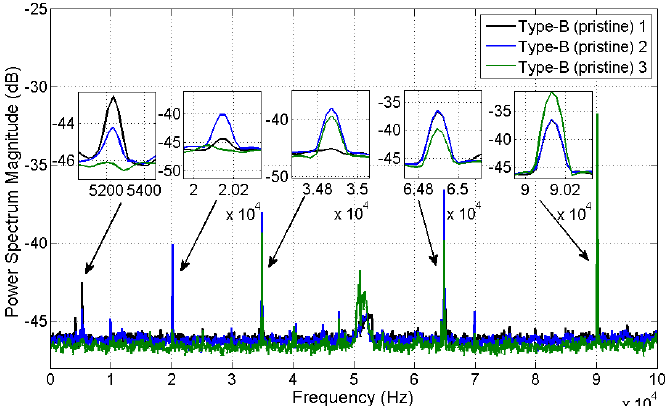
Figure 6. Power spectrum of response of type-B slab tested following procedure P2. Evidence that the hidden strip acts like a sensor providing specific eigenfrequencies are given in the insets.